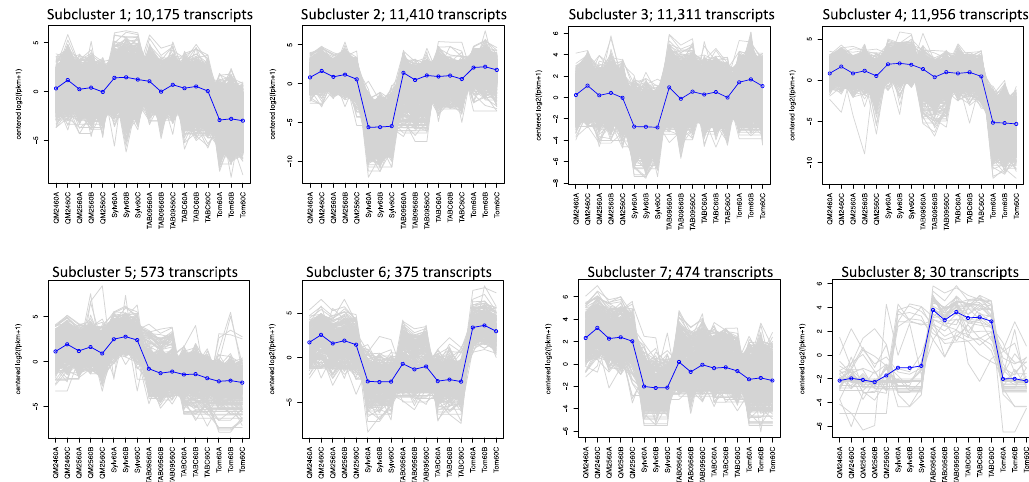
Figure 4. Subclustering of transcripts across all taxa within the 60% of anthesis developmental stage based on hierarchical clustering of di ff erentially expressed genes: the number of transcripts found in each cluster is given. Each gray line is one gene, while the blue line is the mean expression profile for that subcluster. The order along the x-axis for each subcluster plot is synthetic polyploids (QM24 and QM25), N. sylvestris (Sylv), natural polyploids (TAB095 and TABC), and N. tomentosiformis (Tom).